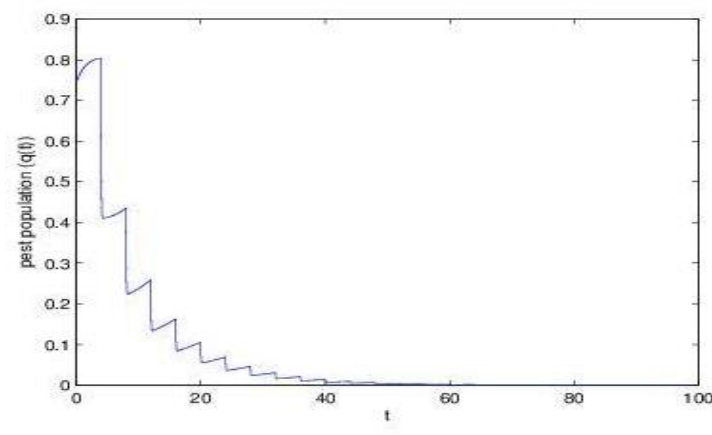
Figure 14. Pest population (𝑞(𝑡)) declines for 𝜇